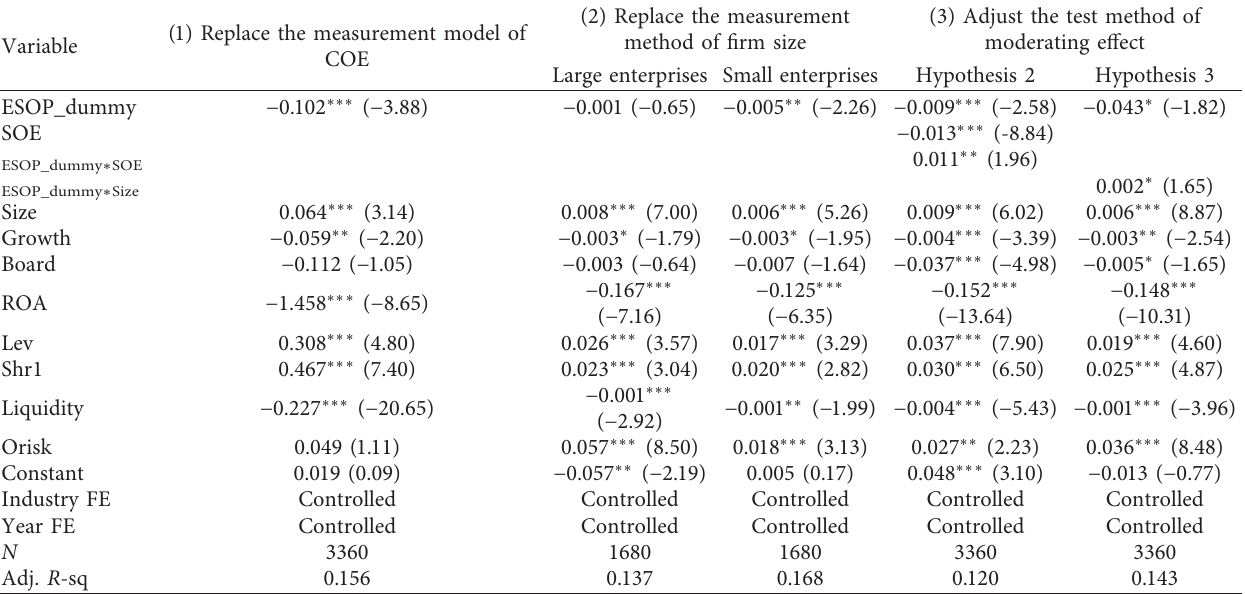
Table 8: Robustness test